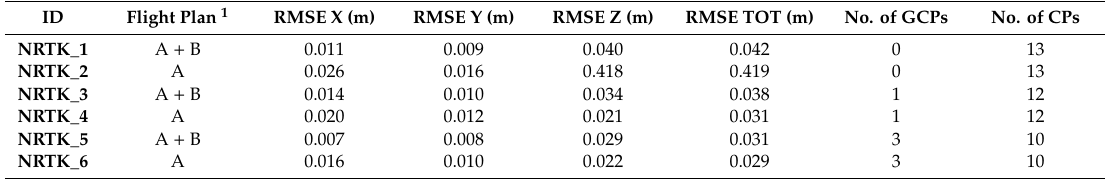
Table 13. (N)RTK approach. RMSE on CPs for configuration from NRTK_1 to NRTK_6.